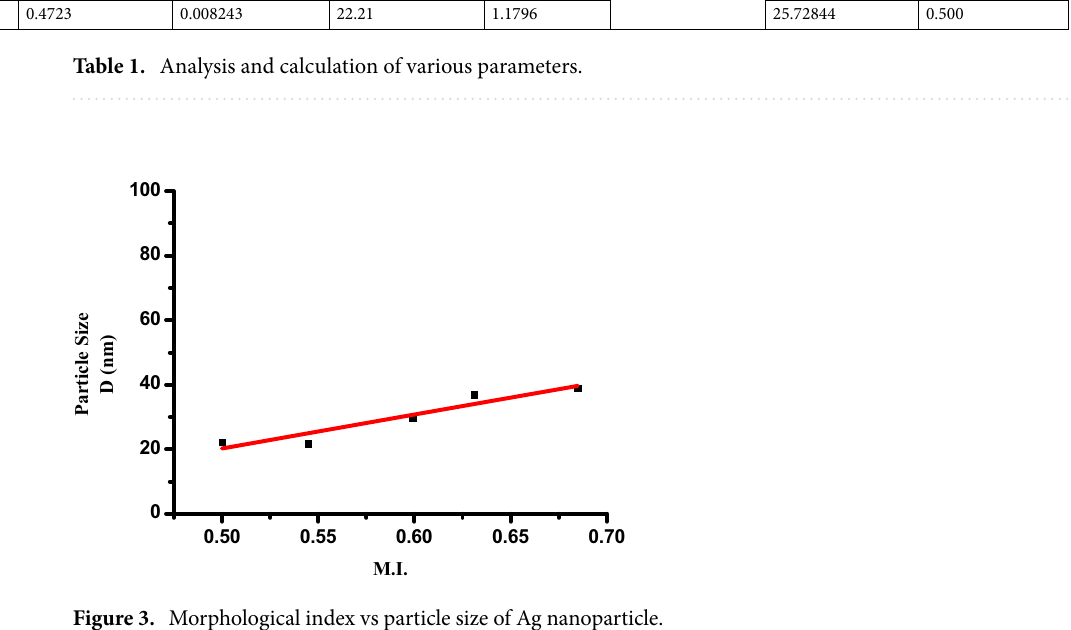
Figure 3. Morphological index vs particle size of Ag nanoparticle.